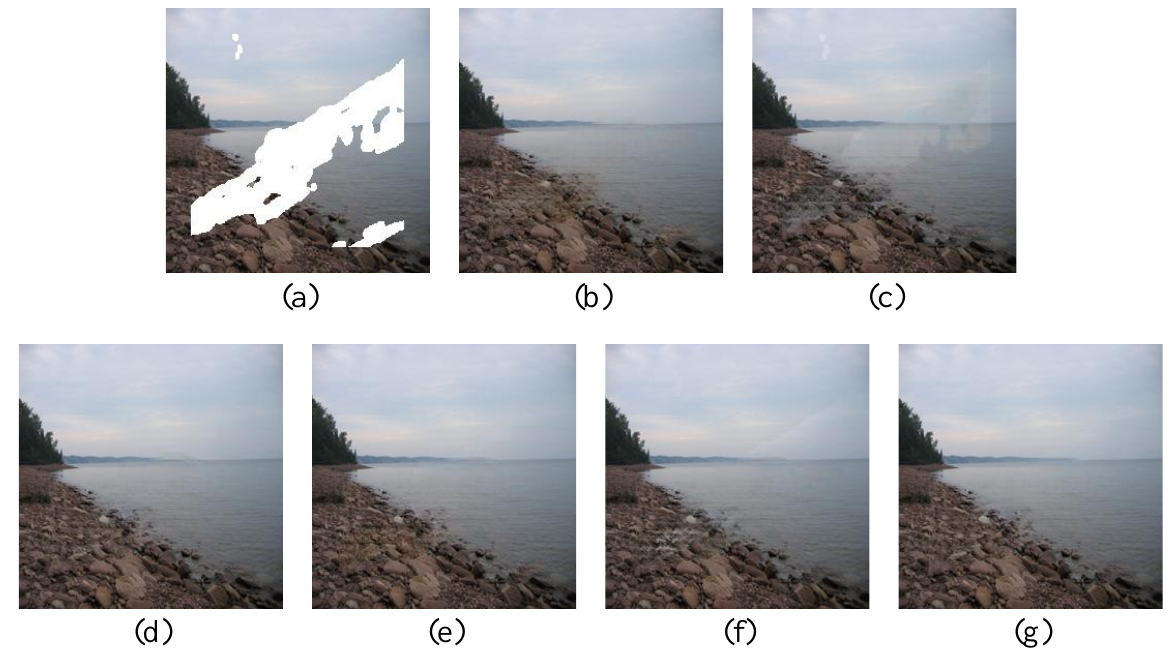
Figure 4. Visual comparison of loss functions. ( a ) Input images. ( b ) W/O feature-matching loss. ( c ) W/O reconstruction loss. ( d ) W/O adversarial loss. ( e ) W/O perceptual loss. ( f ) W/O style loss. ( g ) Result w/ joint